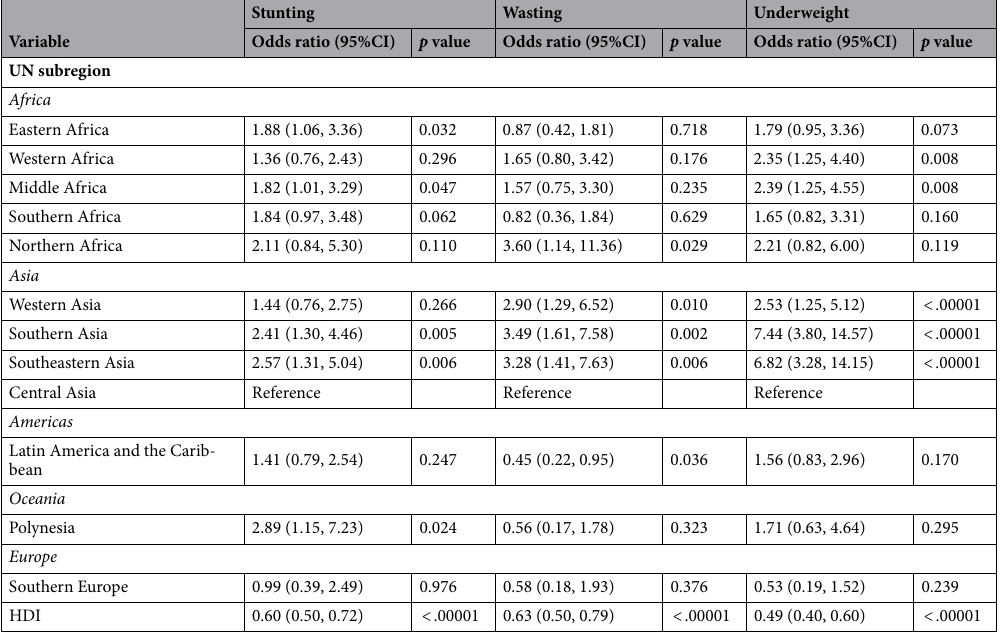
Table 1. Maximum likelihood estimates with associated 95% confidence intervals (CI) for the generalized linear mixed-effects model’s regression coefficients. Odds ratios and their 95% confidence intervals for the association of United Nations regions and Human Development Index with undernutrition (stunting, wasting and underweight). The multivariable model included UN subregions and human development index. R 2 is the coefficient of determination indicating the amount of variation explained by the variables. The R 2 when HDI and UN subregions are included in the random-effects model is 54%, 56%, and 66% for stunting, wasting and underweight. Higher HDI was associated with lower odds of all three forms of